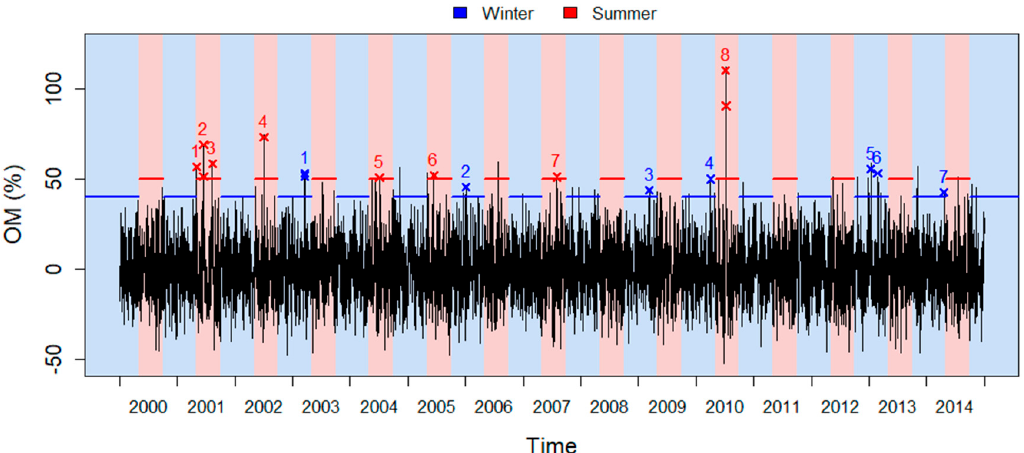
Figure 3. EM series with the identification of EM episodes. Crosses indicate extreme EM days (exceeding s OM ) and the number identifies episodes. Horizontal segments identify s OM . Red areas identify summer and blue ones winter. Note that nonextreme days extending the episodes are not identified here for clarity purposes.